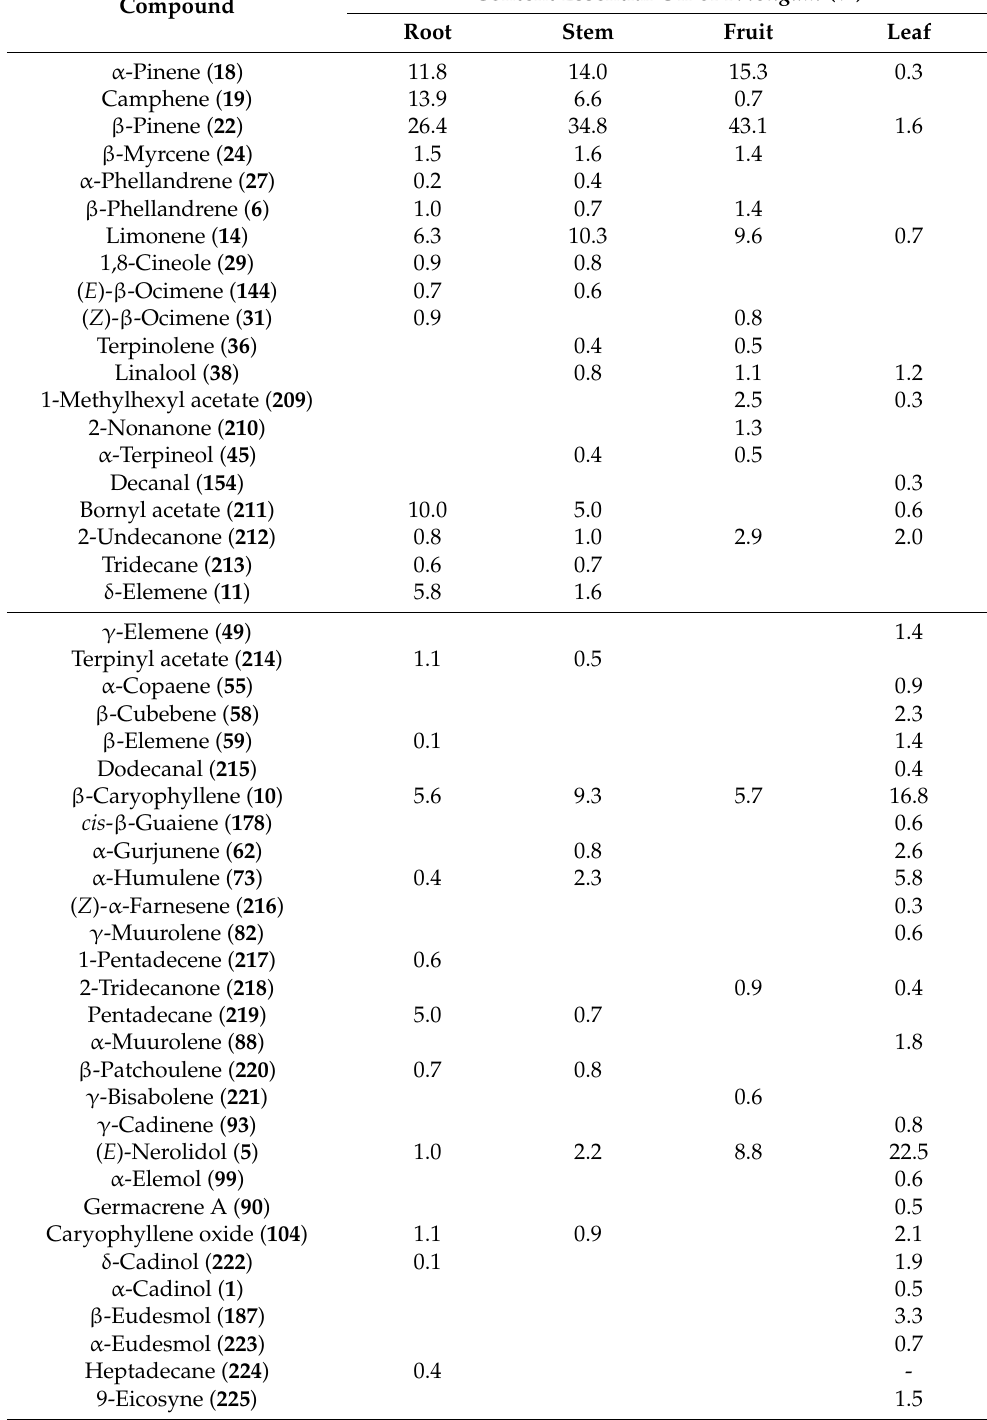
Table 6. Other essential oils’ compositions of P. longum